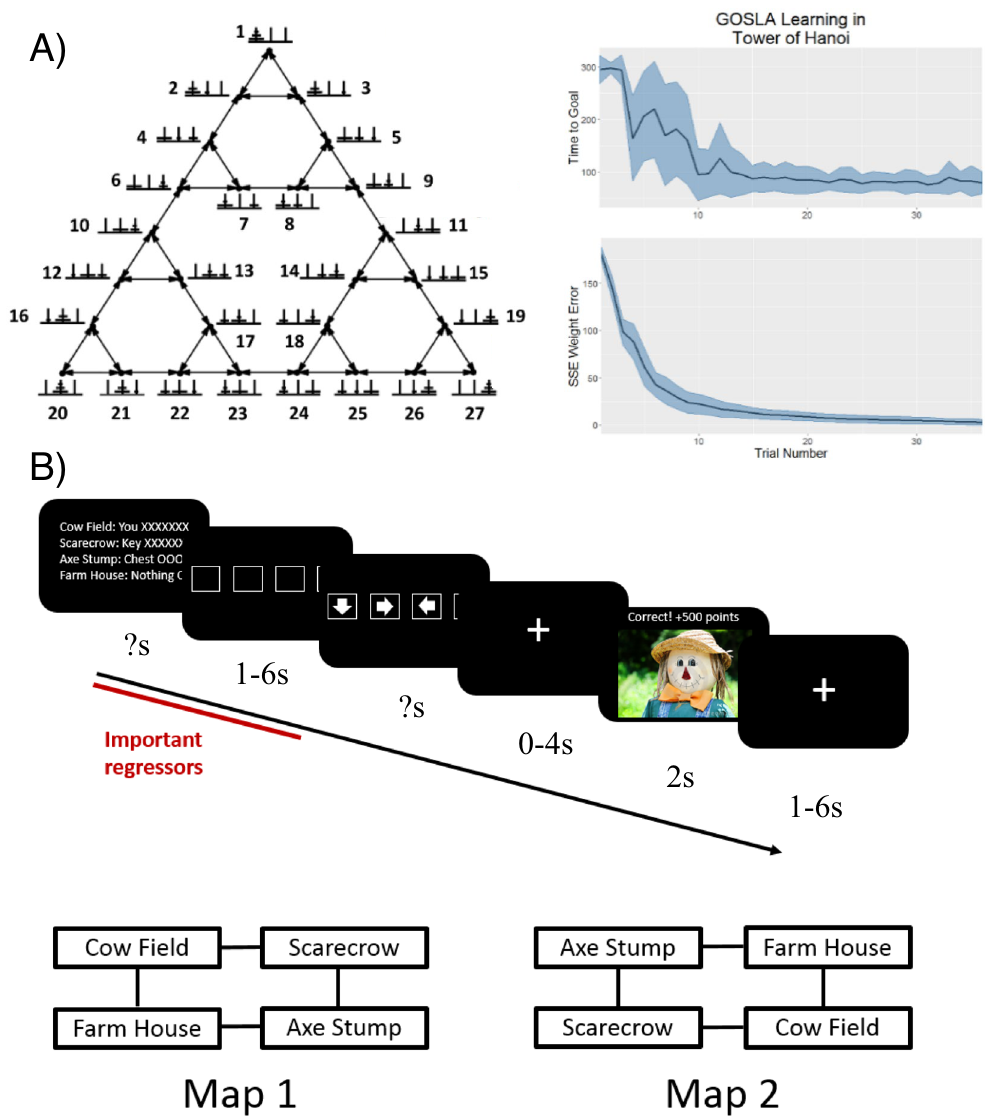
Figure 2. ( A ) The GOLSA model learns to solve problems, achieving arbitrary goal states. It does this by making arbitrary actions and observing which actions cause which state transitions. Figure adapted from earlier work 34, 37 . ( B ) Treasure Hunt task. Both the GOLSA model and the human fMRI subjects performed a simple treasure hunt task, in which subjects were placed in one of four possible starting locations, then asked to generate actions to reach any of the other possible locations. To test multi-step transitions, subjects had to first move to the location of a key needed to unlock a treasure chest, then move to the treasure chest location. Participants first saw an information screen specifying the contents of each of the four states (‘you’, ‘key’, ‘chest’, or ‘nothing’). After a jittered delay, participants selected a desired movement direction and after another delay saw an image of the outcome location. The mapping of finger buttons to game movements was random on each trial and revealed after subjects were given the task and had to plan their movements, thus avoiding motor confounds during planning. Bottom: The two state-space maps used in the experiment. One map was used in the first half of trials while the other was used in the second half, in counterbalanced